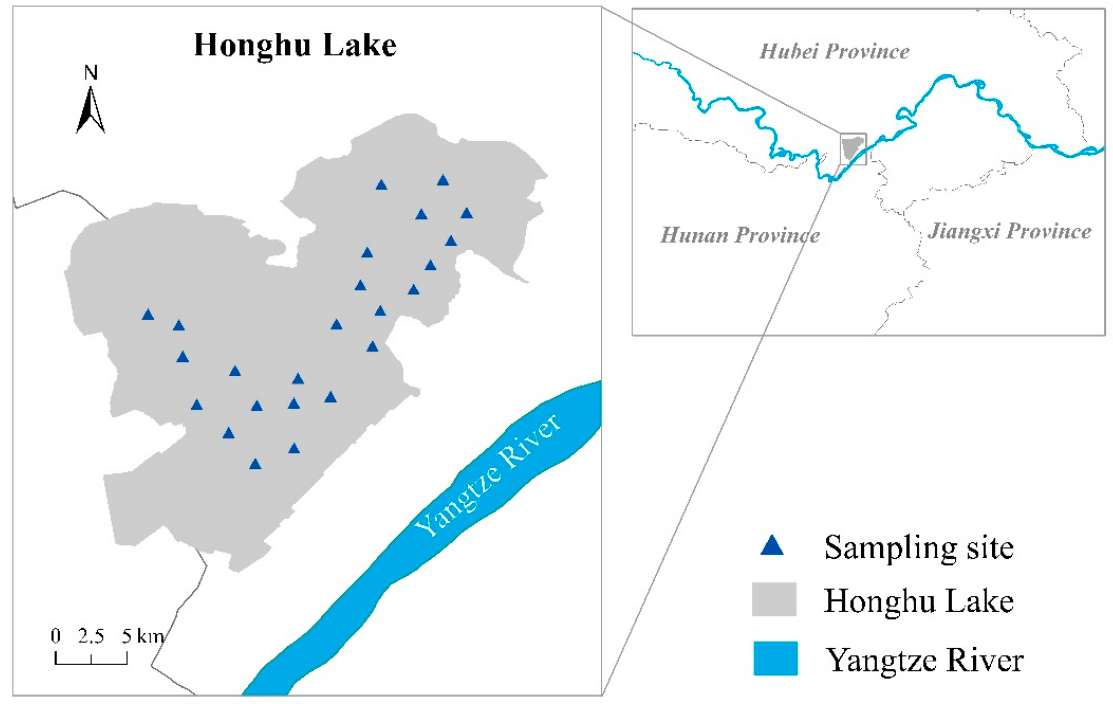
Figure 1. Map of Honghu Lake with 24 in situ sampling sites. It is located in the middle reaches of the Yangtze River.